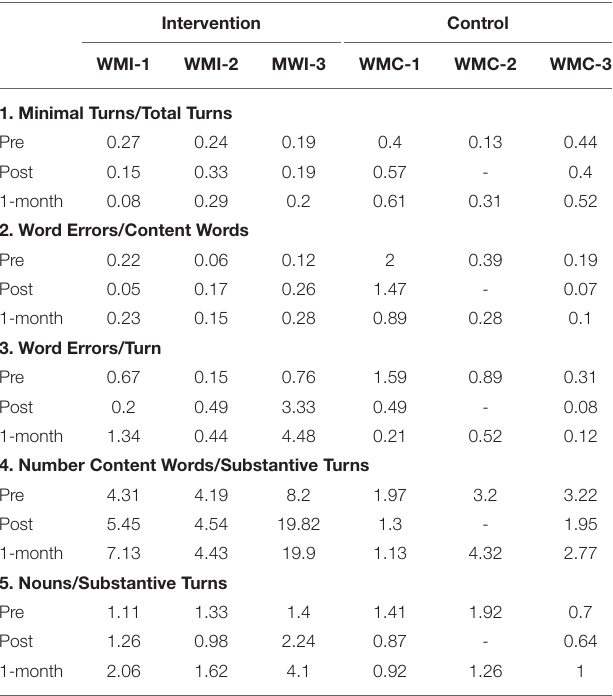
TABLE 4 | Conversational speech analysis using POWERS parameters and associated ratios across participants and assessment times. Intervention